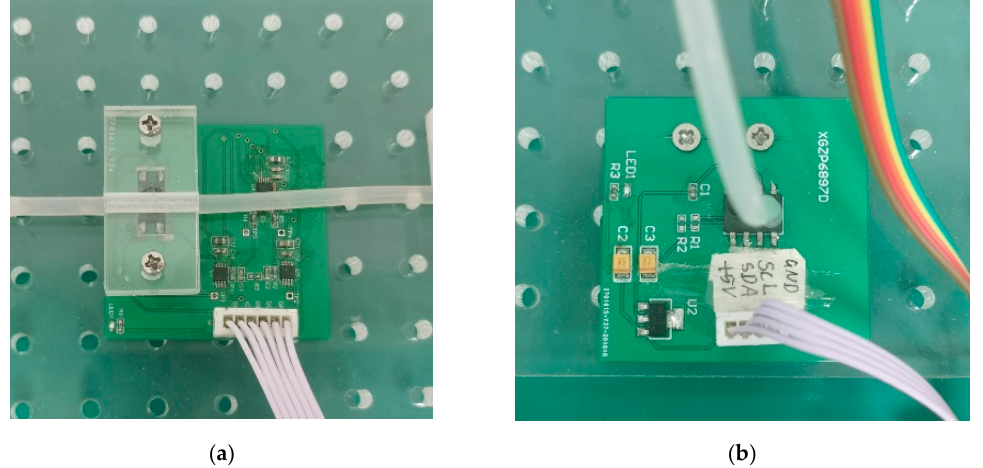
Figure 2. These are two sensors that measure pressure in the pipe. ( a ) The contact force sensor for measuring the internal pressure of the glass tube; ( b ) The pressure sensor for measuring the pressure of silicone tube.